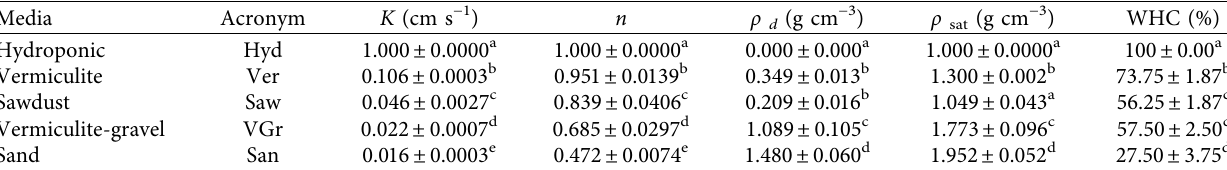
Table 1: Mechanical and hydraulic characteristics of media.